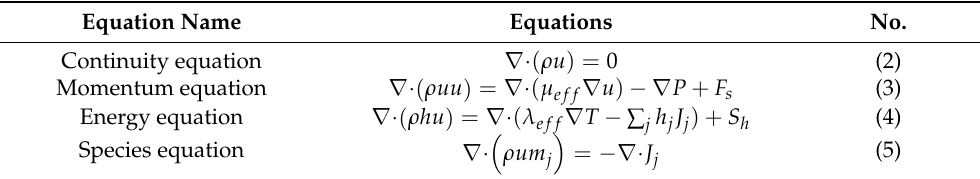
Table 1. Governing